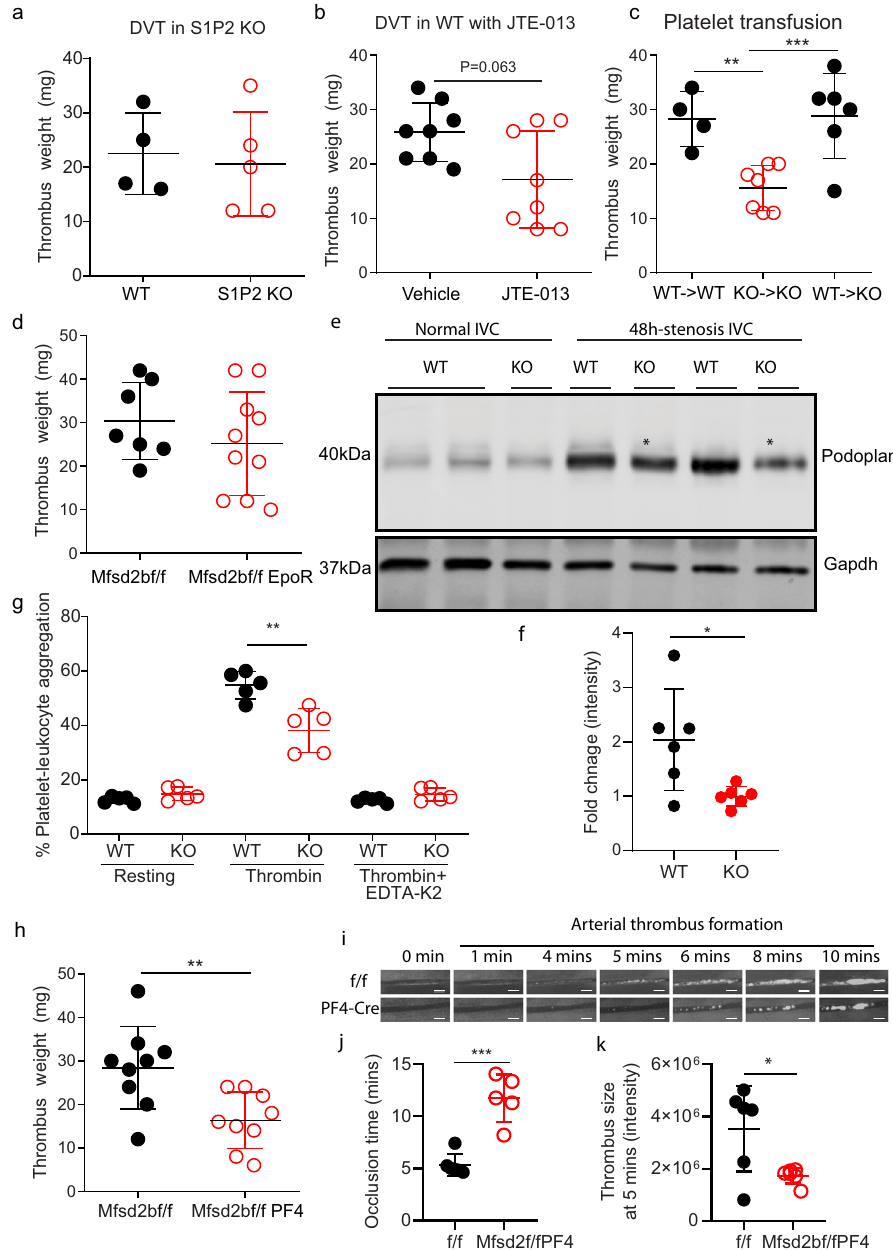
Fig. 8 Deletion of Mfsd2b in platelets reduces thrombosis. a S1P2 is dispensable for thrombosis. Weights of thrombi collected from WT and S1P2 knockout mice. Each dot represents one animal ( n = 4 – 5). b JTE-013, a S1P2 antagonist, also failed to inhibit DVT in mice. Weights of thrombi collected from WT mice ( n = 8) with and without treatment of 30 mg/kg JTE-013. c Platelet transfusion. Transfusion of WT platelet to WT or KO mice, respectively and vice versa. The indicated recipient mice were assessed for DVT. Transfusion of KO platelets failed to increase DVT formation in KO mice, whereas transfusion of WT platelets to KO mice reversed the reduced thrombosis in KO mice. Each dot represents one animal ( n = 4 for WT > WT; n = 7 for KO > KO; n = 6 for WT > KO). ** P < 0.01, *** P < 0.001. One-way ANOVA was used. d Deletion of Mfsd2b in erythrocytes using EpoR-cre did not reduce thrombosis. Each dot represents one animal ( n = 7 – 10). e , f Expression of podoplanin in untreated and stenosis IVC from WT and KO mice. In stenosis IVC, thrombi were removed from IVC for western blot analysis. Each dot represents one mouse ( n = 6). * P < 0.05. Two-tailed unpaired t -test was used. g Flow cytometry assays of platelets-leukocyte aggregate assays showed that activated Mfsd2b KO platelets exhibited reduced aggregation with leukocytes in comparison with activated WT platelets. See supplementary fi g. 10 for gating strategy. Each dot represents one mouse ( n = 5). ** P < 0.01. One-way ANOVA was used. h Deletion of Mfsd2b in platelets using PF4-cre reduced thrombosis. In the DVT experiments, thrombus weight after 48 h of stenosis were measured. Each dot represents one animal ( n = 9). ** P < 0.01. Two-tailed unpaired t -test was used. i Time lapse imaging of thrombus formation in mesenteric arteries of Mfsd2bf/f (f/f) and Mfsd2bf/fPF4 (PF4-Cre) mice. j Occlusion time of blood fl ow in mesenteric artery during thrombosis from Mfsd2bf/f and Mfsd2bf/fPF4 mice. Each dot represents one mouse ( n = 6 for Mfsd2bf/f; n = 5 for Mfsd2bf/fPF4). *** P < 0.001. Two-tailed unpaired t -test was used. k Thrombus sizes quanti fi ed by fl uorescence intensity of the thrombus occurred at 5 min from Mfsd2bf/f and Mfs2bf/fPF4 miceEach dot represents one animal ( n = 6). * P < 0.05. Two-tailed unpaired t -test was used. Scale bars in i : 100 μ m. Data are mean and SD in all